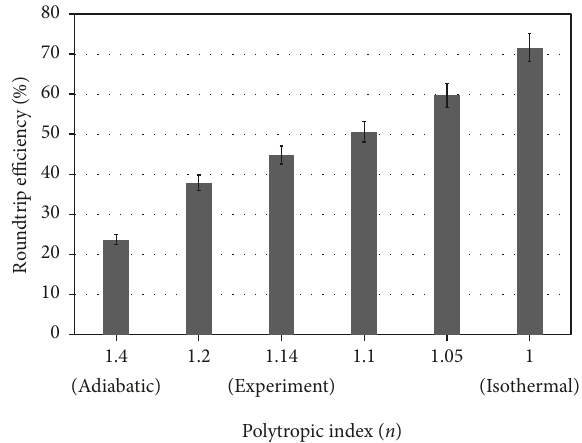
Figure 10: Roundtrip efficiency of liquid piston based OCAES for different polytropic